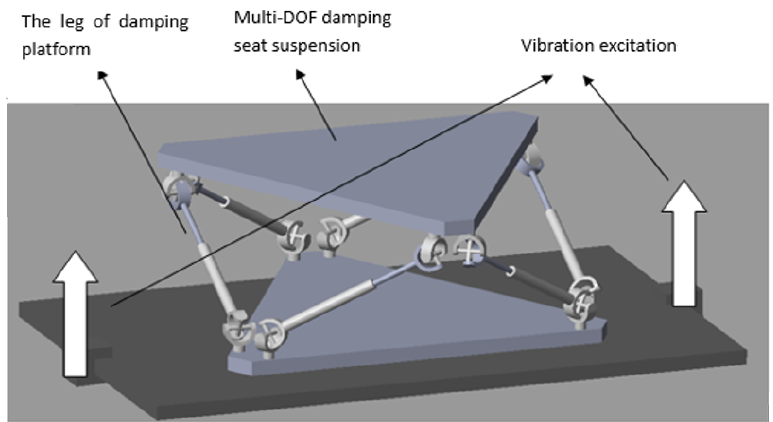
Figure 24. Semi-active control simulation model of multi-dimensional vibration-damping seat.